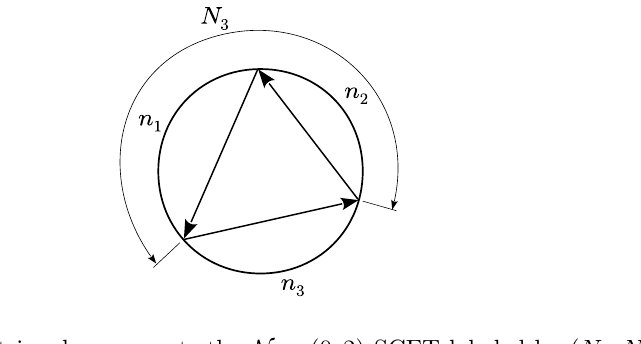
Figure 6 . The oriented triangle represents the N = (0 ; 2) SCFT labeled by ( N 1 ; N 2 ; N 3 ) modulo cyclic